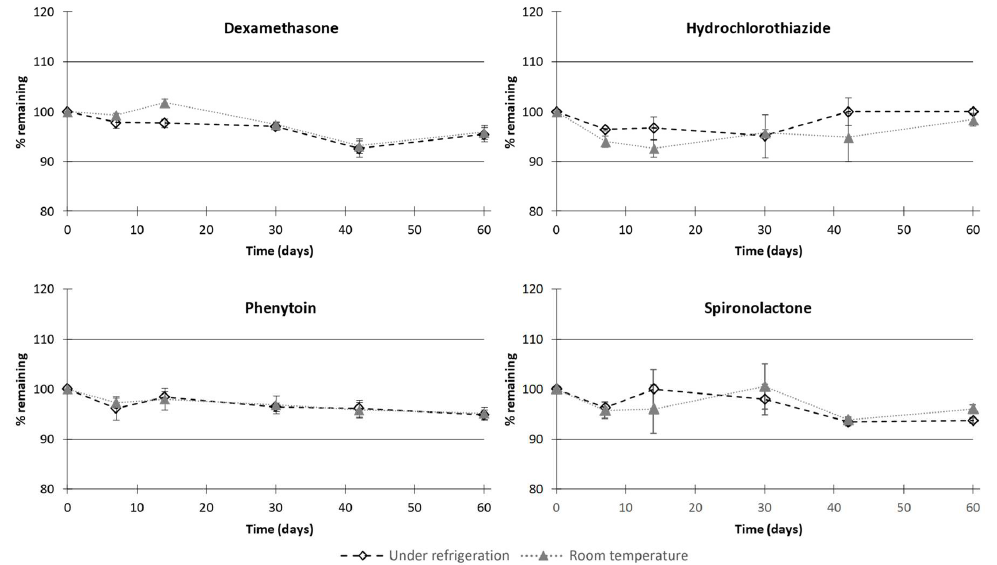
Figure 5. Chemical stability of dexamethasone, hydrochlorothiazide, phenytoin, and spironolactone in compounded oral suspensions in all storage conditions. Values are expressed as mean percentage remaining ± standard deviation.